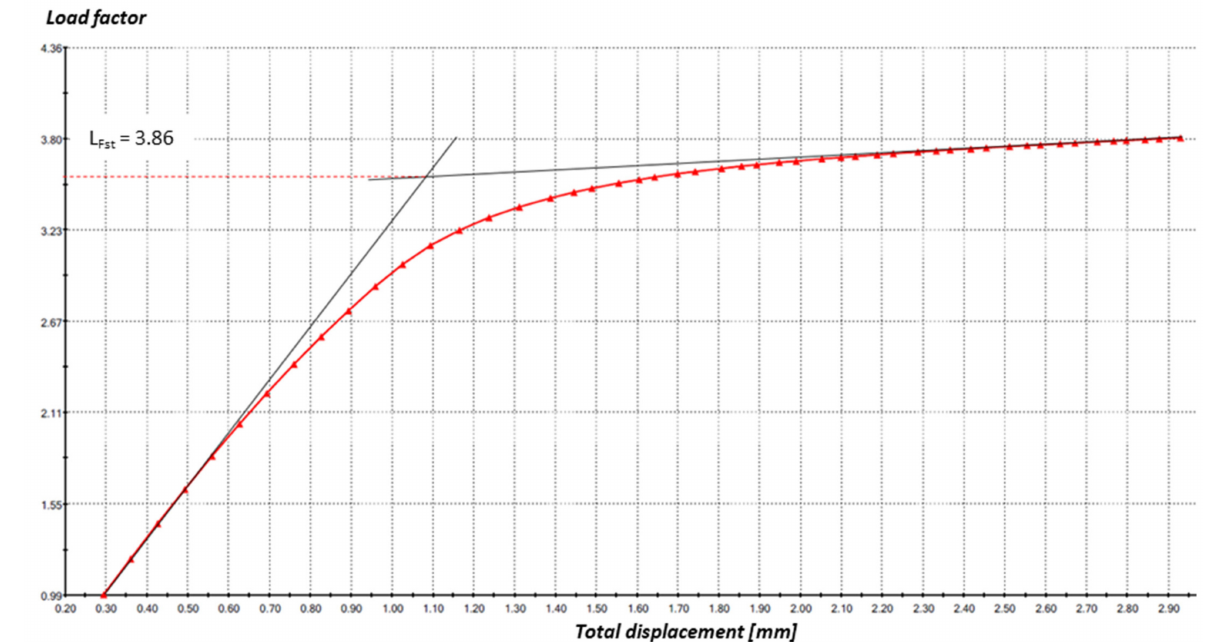
Figure 9. Load characteristics at the node 46 439.